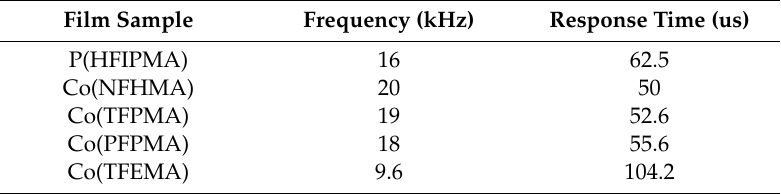
Figure 5. The result of pressure and PSP fluorescence signal under the frequency of ( a ) 4 kHz; ( b ) 16 kHz and ( c ) 20 kHz. Table 3. Response frequency and response time of five kinds of PSP samples.